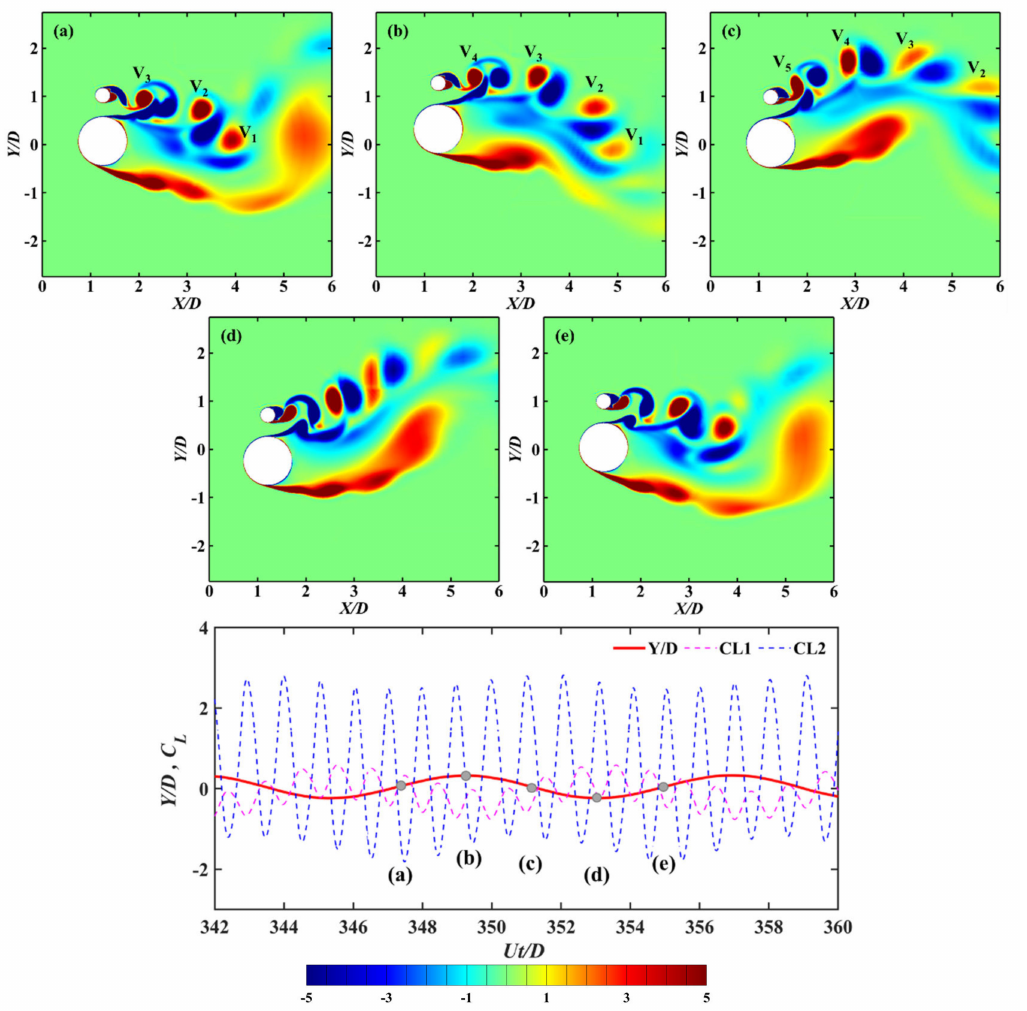
Figure 16. Instantaneous vorticity contours for the typical time instants in one vibration period at d/D = 0.3, α = 90 ◦ , and U r = 10: ( a ) Ut/D = 347.4; ( b ) Ut/D = 349.3; ( c ) Ut/D = 351.2; ( d ) Ut/D = 353.1; ( e ) Ut/D =